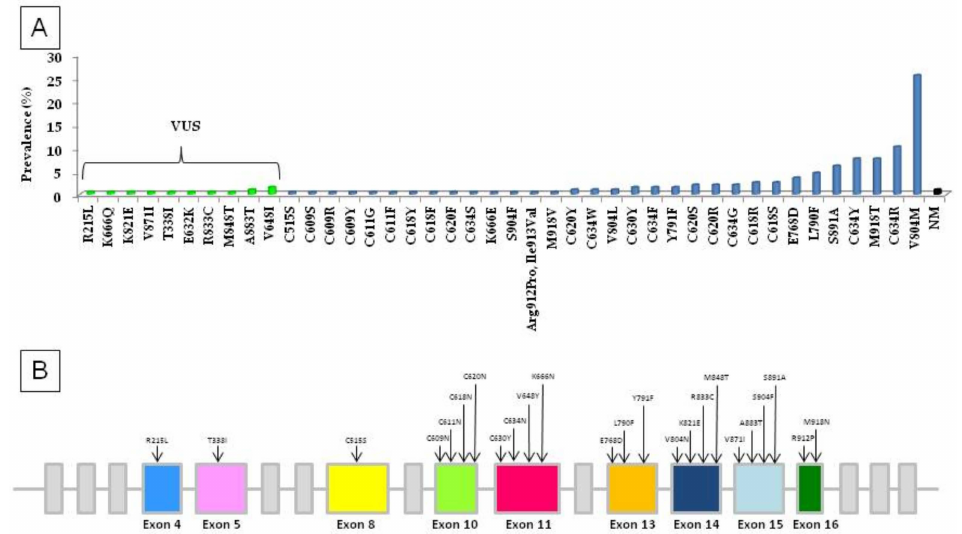
Figure 2. Prevalence ( A ) and distribution along the gene ( B ) of RET germline mutations in our series. In this series 11 mutations were variants of unknown significance